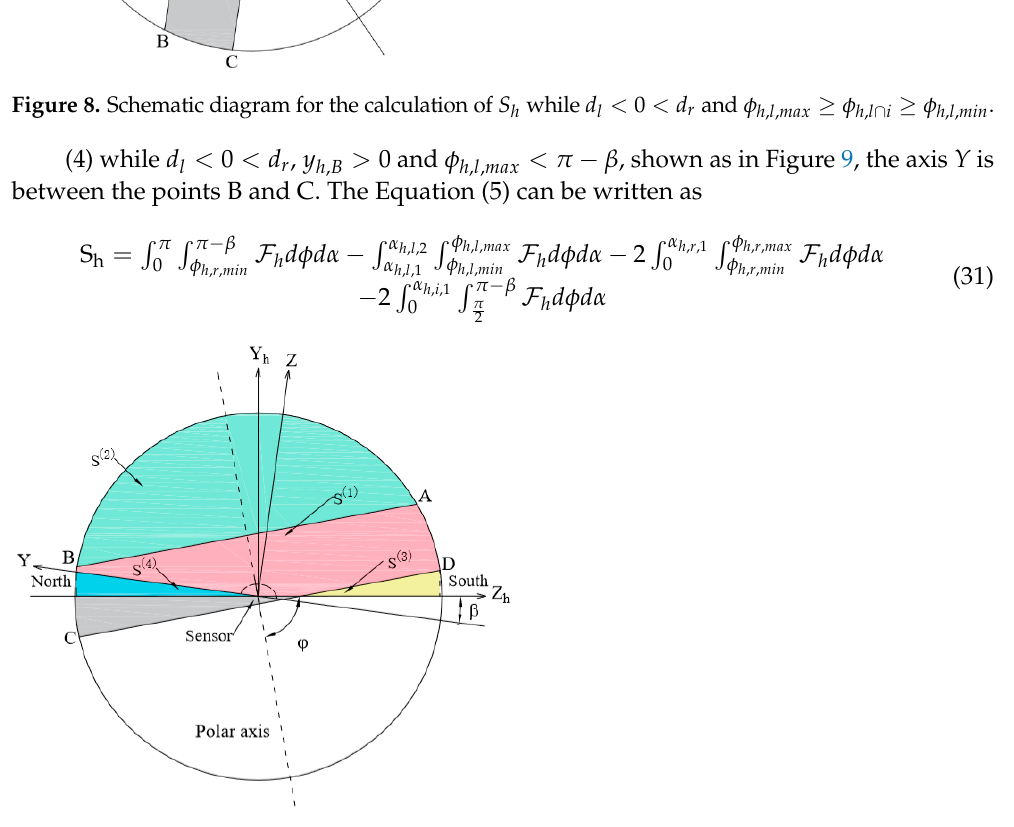
Figure 9. Schematic diagram for the calculation of S h while d l < 0 < d r , y h , B > 0 and φ h , l , max < π − β .